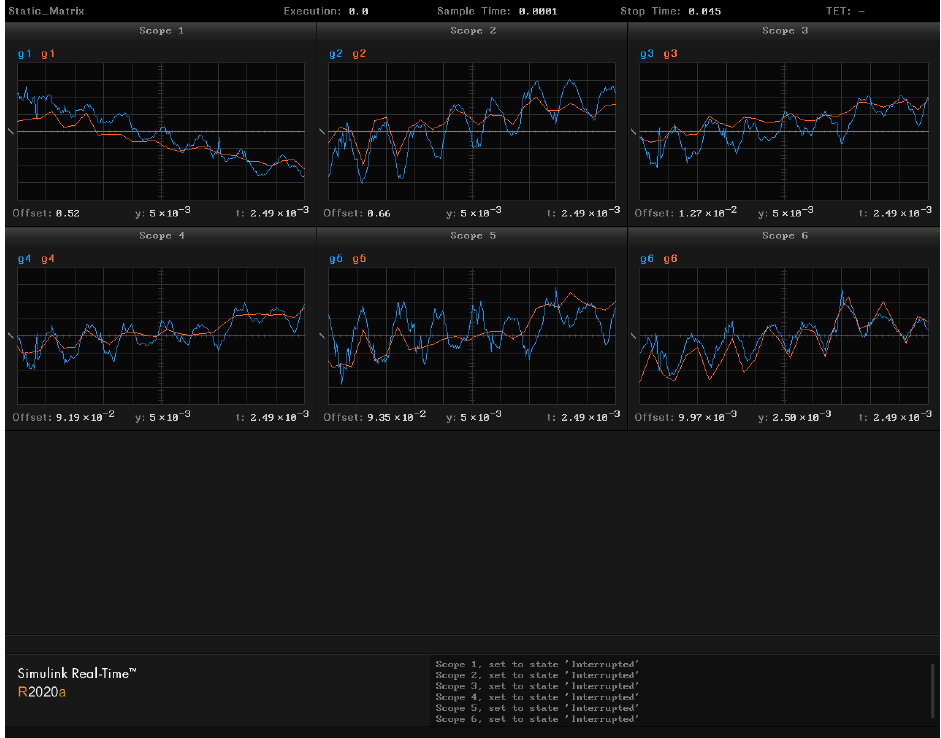
Figure 17. Real-time simulation of gaps g derived by LTI model obtained from the FCDI code (blue line) and estimation of gaps ˜ g obtained from static matrix (red line). Discharge